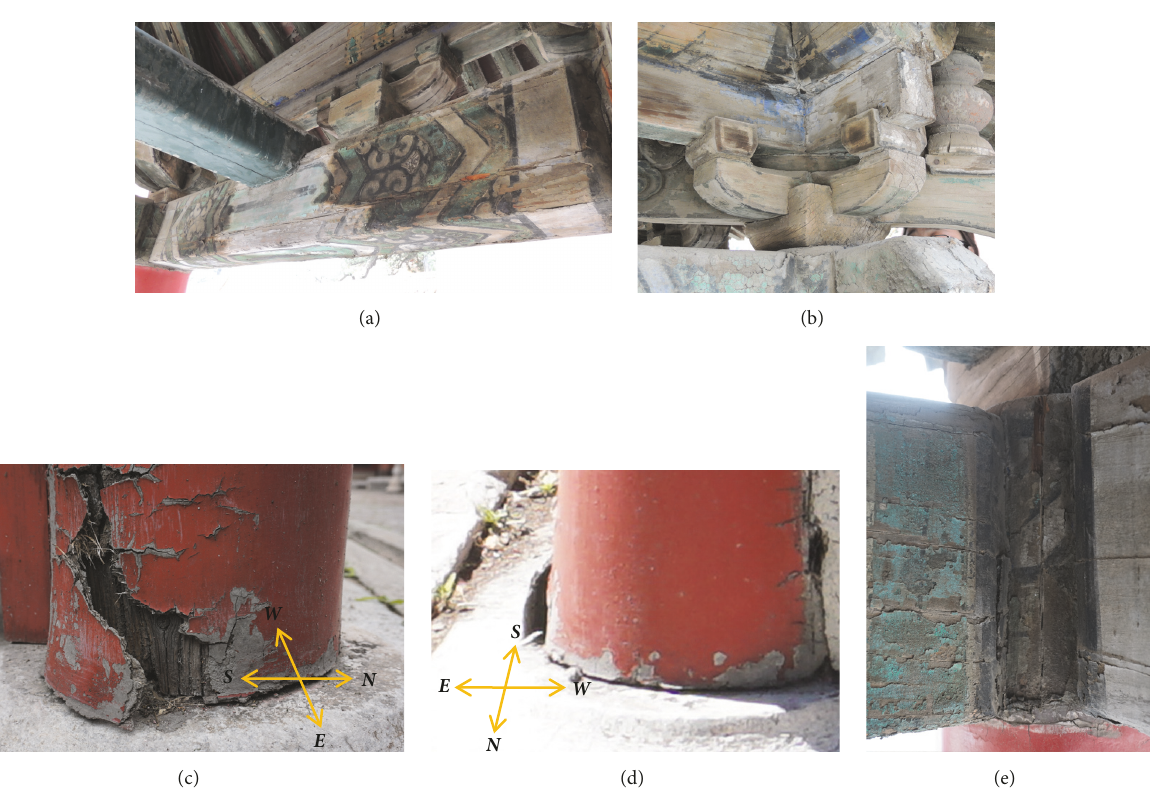
Figure 12: Structural damage phenomena: (a) crack on the surface of the beam; (b) compression deformation of Dou Gong; (c) serious decay of column foot in east side; (d) north side of column foot in relatively good condition; (e) cracks and decay at the column top.